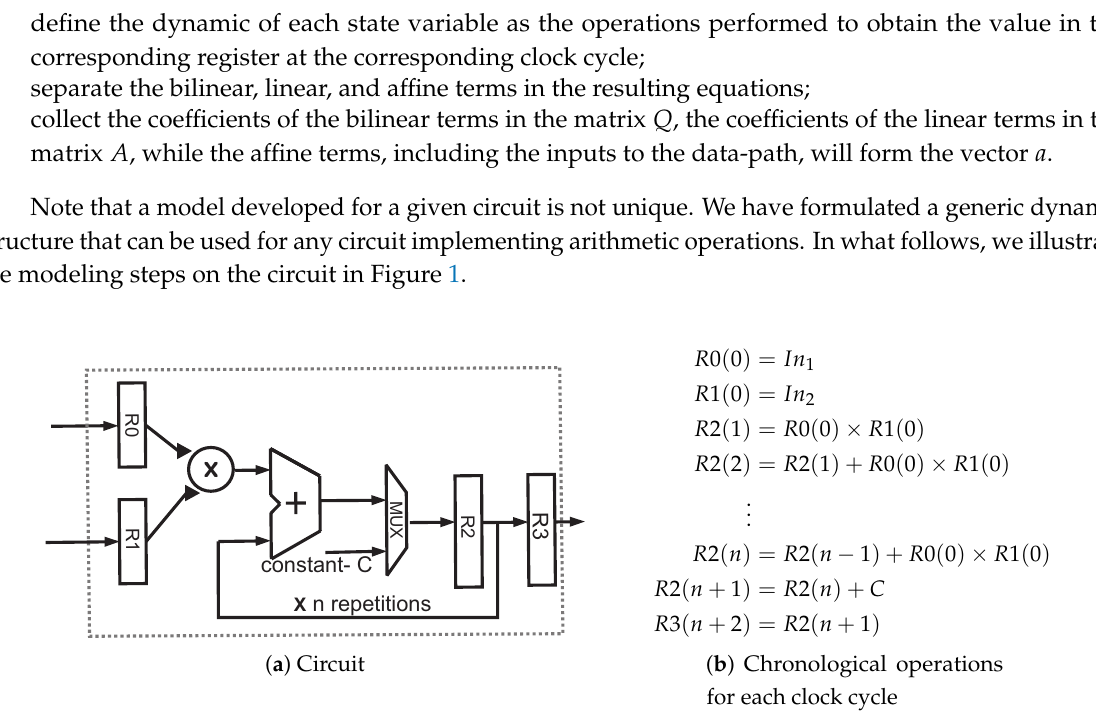
Figure 1. Modeling example: Ri ( m ) denotes the value assigned to register Ri at the clock cycle m , and In 1 and In 2 are the multiply-accumulate (MAC) design unit